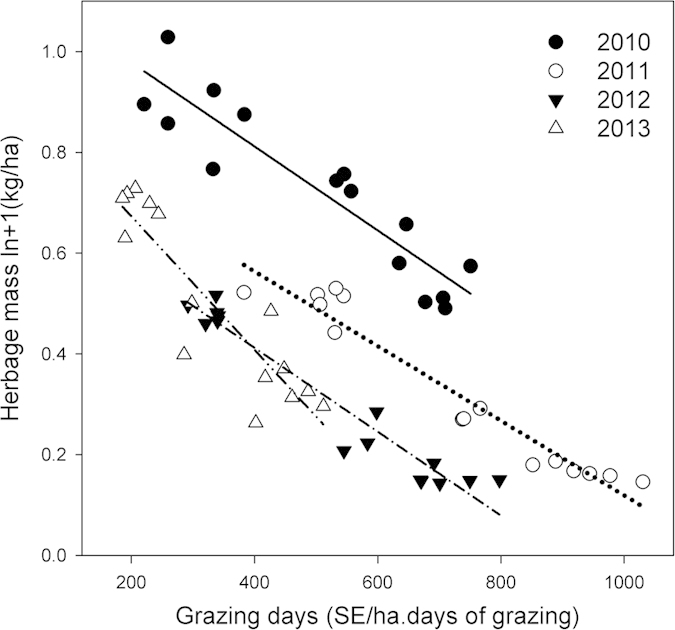
The relationship between average grazing season herbage mass ln +1 (kg DM ha−1) and SE grazing days ha−1 year−1 (1 SE = a 50 kg reference weight animal); Adj R2 = 0.94) between 2010 and 2013 (2010, Y = −0.00083X + 1.1451; 2011, Y = −0.00074X + 0.86; 2012, Y = −0.00083X + 0.7452; 2013, Y = −0.0013X + 0.9387).